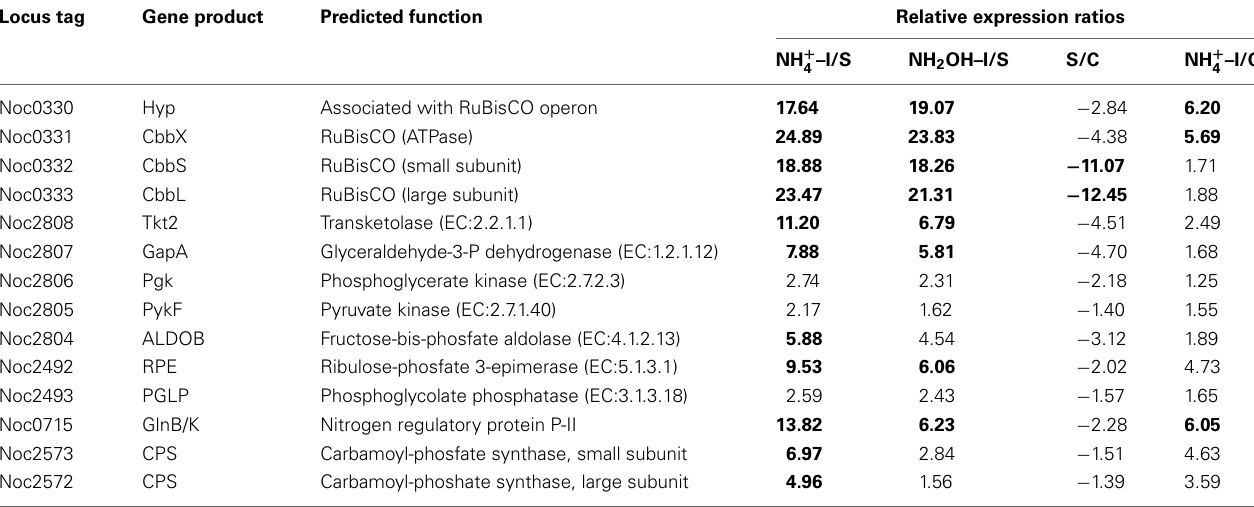
Table 2 | Expression ratios of genes and gene clusters in catabolic modules for “Carbon Fixation and Assimilation” and “Nitrogen